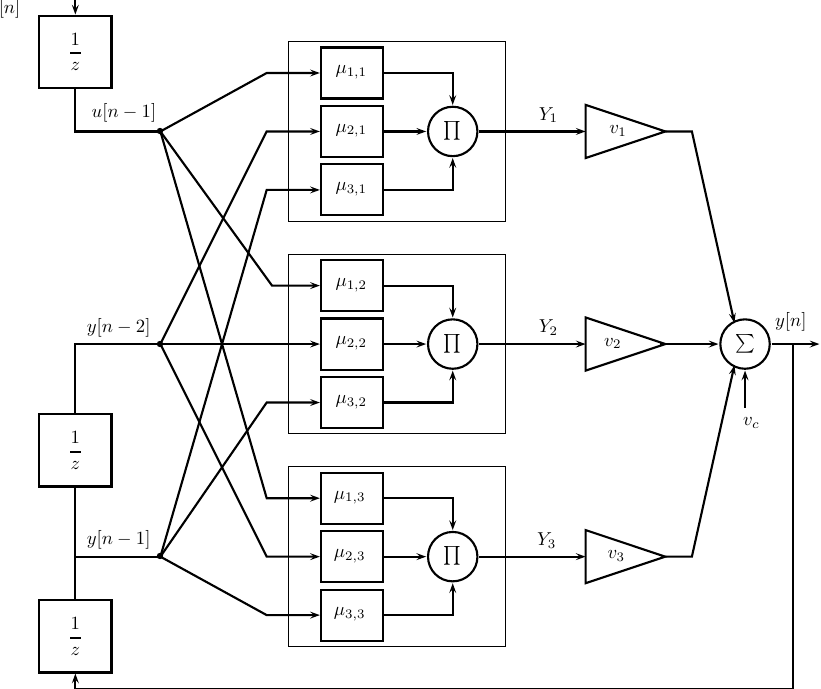
Figure 9. Configuration of the neuro-fuzzy systems for identification and